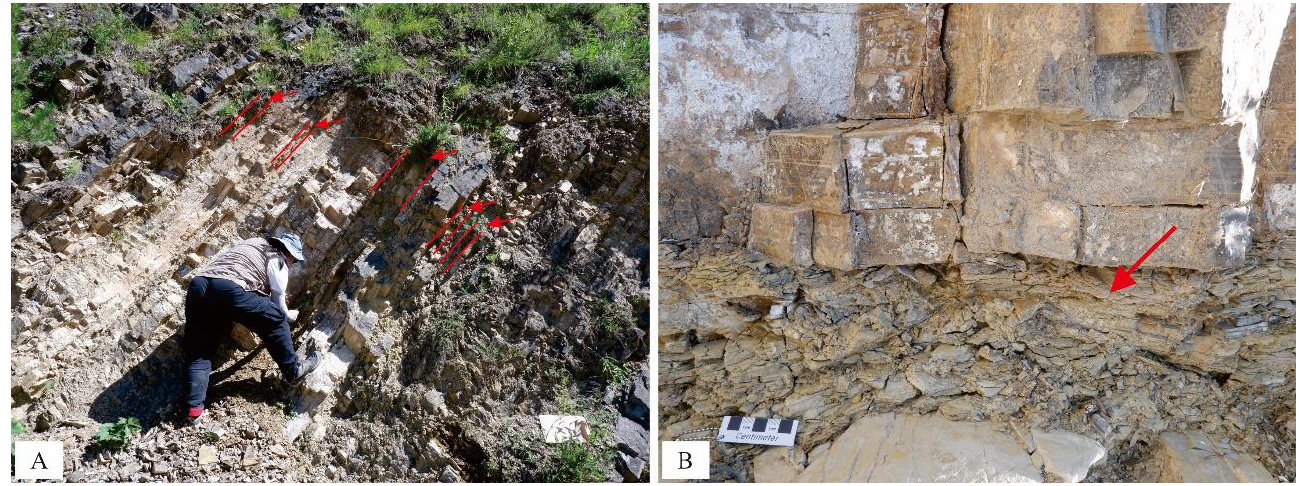
Figure 10. ( A ) Multilayer tuff in the Pingliang Formation Guanzhuang section; ( B ) the upper layer is marl and the lower layer is tuff of the Pingliang Formation Guanzhuang section. The red lines indicate boundaries between tuff and shale, and the arrows point to layers of tuff.